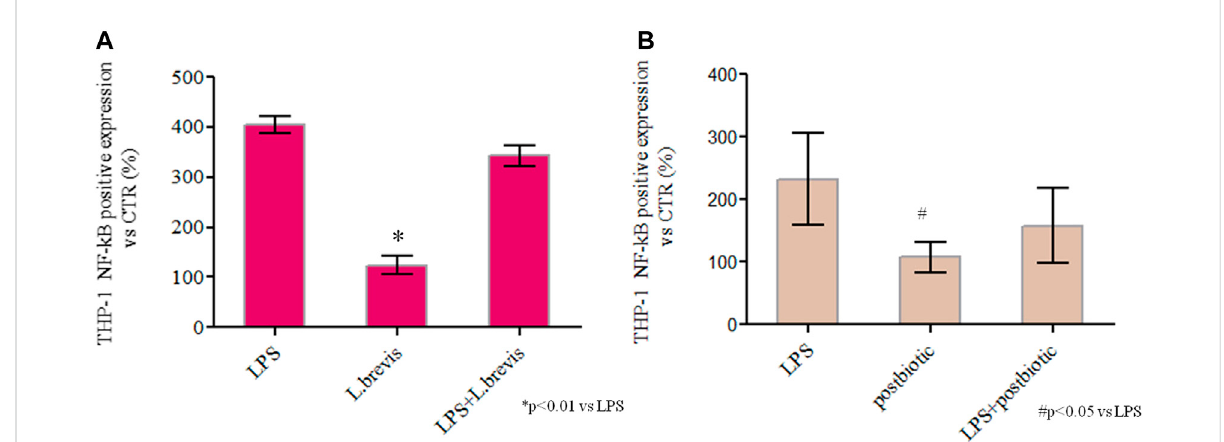
FIGURE 6 Spectrophotometric quanti fi cation of NF- κ B by QUANTI-Blue ™ assay in untreated cells (CTR) or cells exposed to commercial LPS from Salmonella , L.brevis ,andpotentialpostbioticssecretedfrom L.brevis andpartiallypuri fi edasdescribedinthetext. (A) CellstreatedwithLPS,LPS+ L. brevis, and L. brevis alone (B) Cells treated with LPS, LPS + postbiotics and postbiotics alone (B) . The assay was performed in duplicate, cells were treated with the same batch of postbiotics. The results are shown as average ± SD and normalized with respect to CTR (%). Student t-test was used for the evaluation of statistical differences and indicated as * p < 0.01 and # p < 0.05 vs.